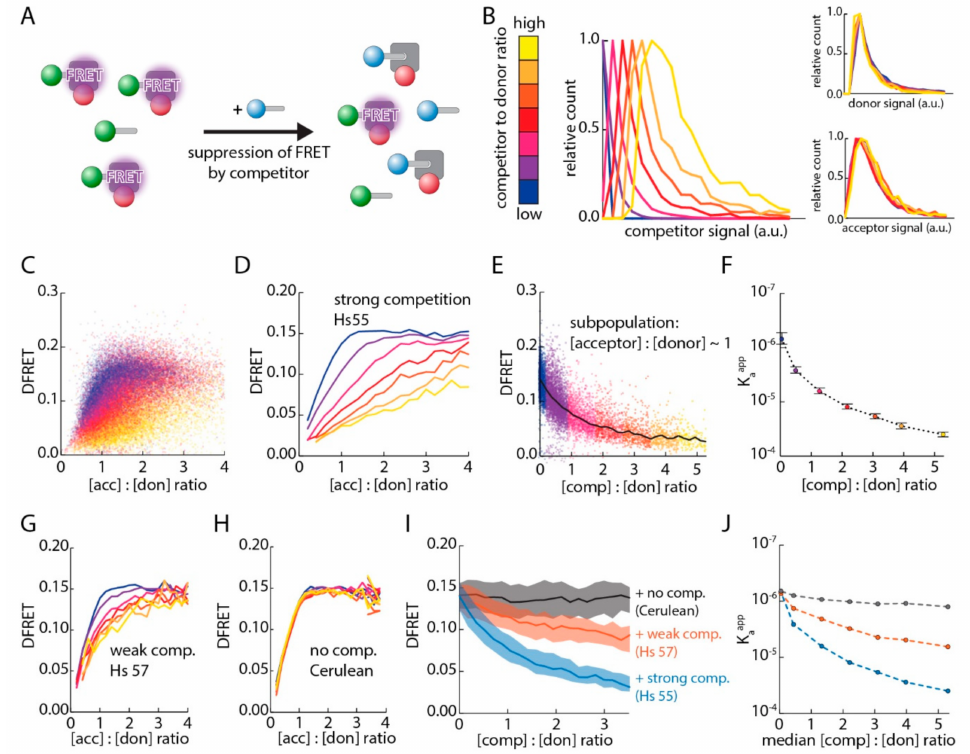
Figure 4. Establishing a live-cell competition assay: ( A ) Schematic representation of a FRET-based competition assay: Cerulean-PTS1 (blue) reduces the fraction of mCherry-PEX5 TPR (red) engaged in a FRET-producing interaction with EGFP-PTS1 (green); ( B – F ) FlowFRET measurements of pex5 − / − cells expressing mCherry-PEX5 TPR and EGFP-PTS1 (Hs55) together with varying amounts of Cerulean-PTS1 (Hs55); seven equally sized populations of cells were generated according to the competitor to donor ratios and thus the average amount of competitor protein was clearly di ff erent among these populations (left panel), whereas the distribution of donor and acceptor were comparable (right panels) ( B ); subpopulations were highlighted by color-code and are depicted by the DFRET values of individual cells ( C ) or by the saturation curves ( D ); ( E ) when plotting the DFRET values of cells sharing acceptor-to-donor ratios of around one (0.8 < x < 1.2) against the competitor to donor ratio, a traditional decay curve is obtained; ( F ) fitting the seven data sets independently (cf. ( B )) allows the extraction of their K a app s, which were plotted against the competitor-to-donor ratio (fitting estimate ± s.e. of fit); ( G , H ) saturation curves of corresponding competition experiments utilizing a competitor with lower a ffi nity to PEX5 (Cerulean-PTS1, Hs57) ( G ) or Cerulean alone ( H ); ( I ) DFRET decay curves for competitors with high (Hs55, blue) or low a ffi nity (Hs57, red) to PEX5 TPR or for Cerulean alone (grey) using cells with an acceptor-to-donor ratio of around one; ( J ) fitting equally sized data sets allows the extraction of K aapp in the presence of di ff erent competitor-to-donor ratios for Cerulean–PTS1 with a high (blue) or low (orange) a ffi nity to PEX5 or for Cerulean alone (grey). Statistics: ( B – F ) ( n =